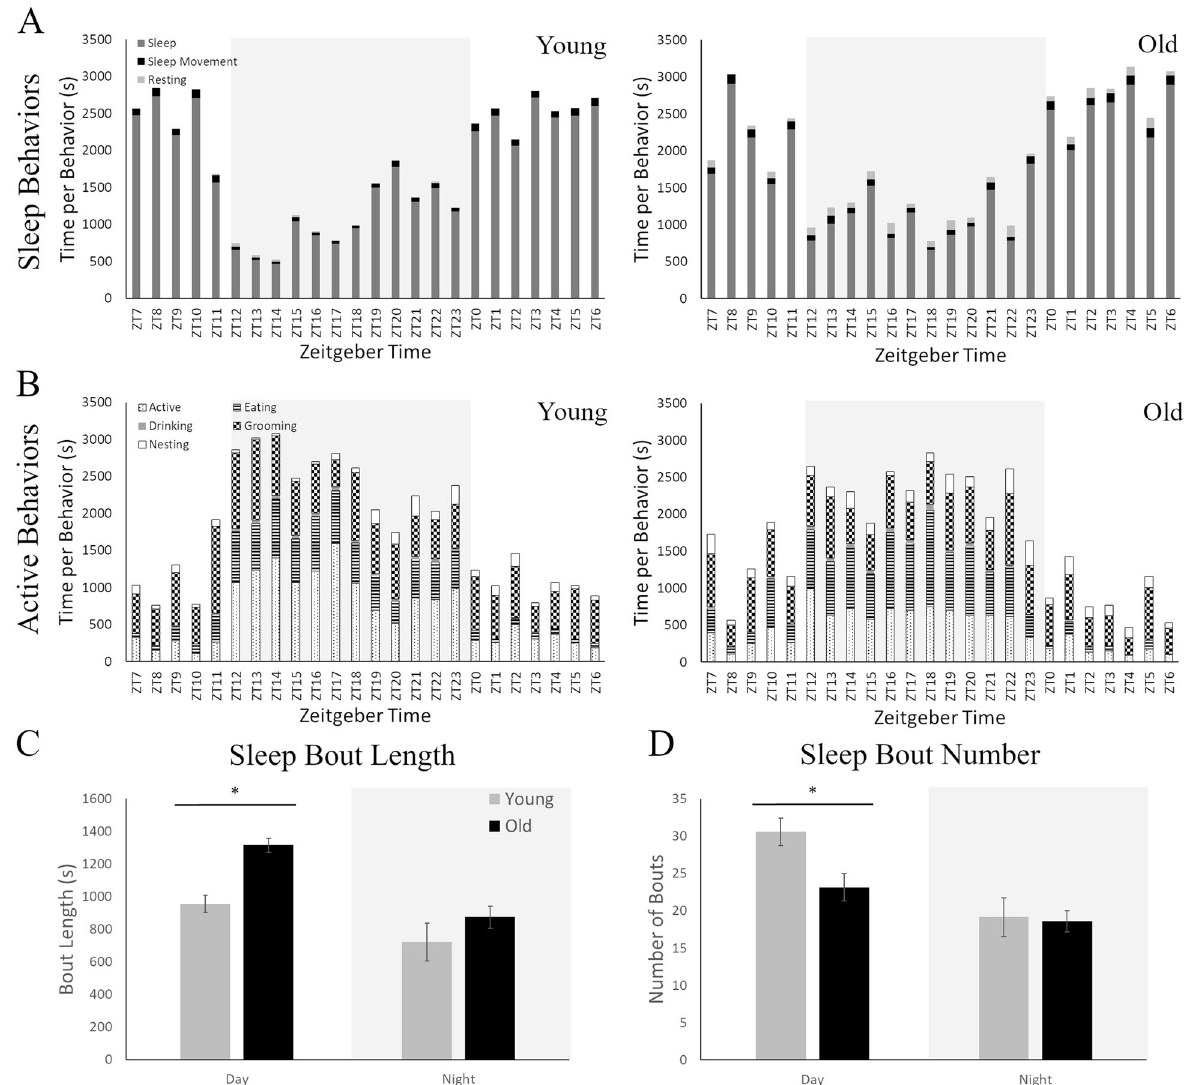
Fig. 3 Sleep analysis of young and old mice using the manual video scoring technique. A Sleep-like behaviors plotted across 24 h in seconds spent for each behavior where ZT0 is lights on and ZT12 is lights off. These behaviors include sleep, sleep movement, and resting. The light gray highlighted area indicates the nighttime (active period) while white indicates the daytime (inactive period). Both young (left panel) and old (right panel) mice sleep less during the night, as mice are nocturnal animals. Young animals, however, do not display resting behaviors (light gray) while old animals have many periods of rest across the day. B Active behaviors plotted across 24 h in seconds spent for each behavior at the hour level. These behaviors include active (walking, climbing, rearing, and snif fi ng), eating, drinking, grooming, and nesting. Young animals spend more time engaging in active behaviors during the night than their older counterparts. C Analysis of the length of sleep bouts was signi fi cantly higher in old mice only during the daytime. D The number of sleep bouts showed the opposite pattern with signi fi cantly higher number in young mice, again only during the daytime. * p <